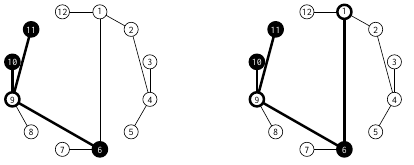
Fig. 3: Selecting the nodes (cid:1) 6